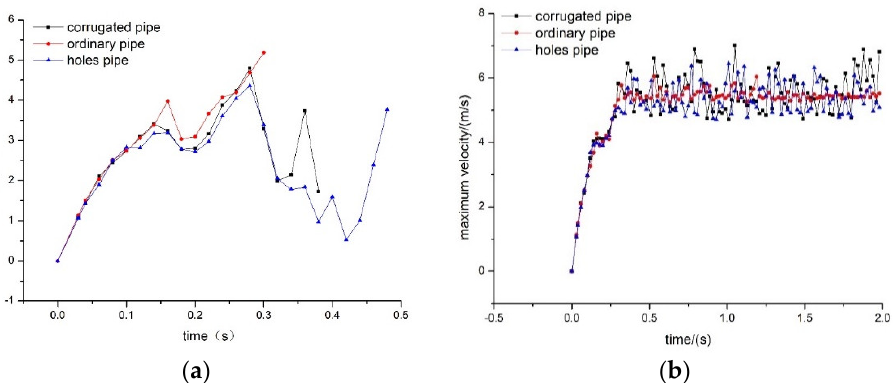
Figure 10. Plot of single particle velocity variation and maximum particle velocity in seed tube. ( a ) Effect of seed tube on stress of single seed; ( b ) Influence of seed tube on maximum force of seed.